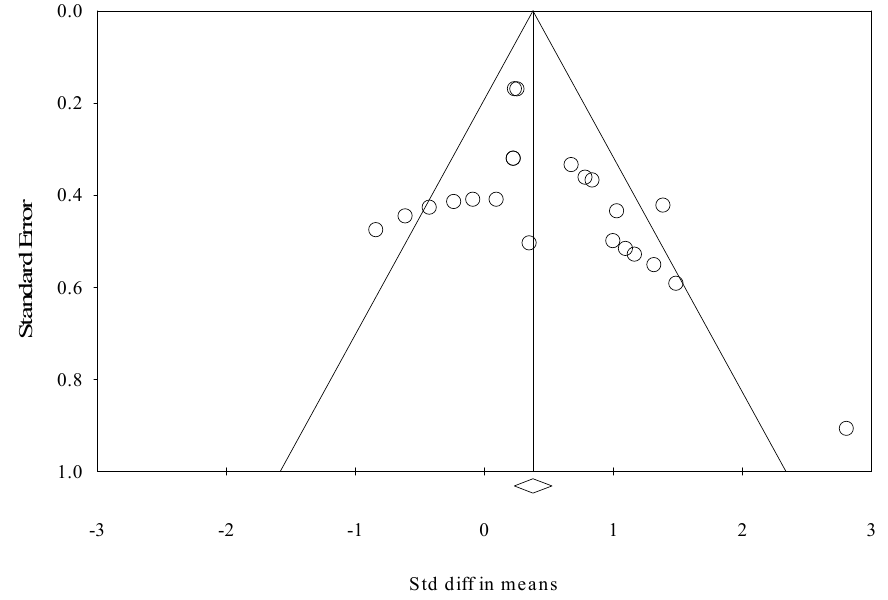
Figure 3. Funnel plot displaying tDCS and TMS effects for the assessment of publication bias.